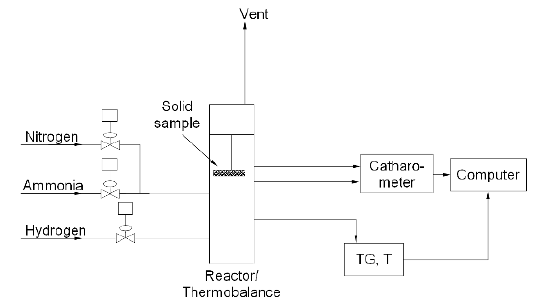
Figure 1. Reactor with thermogravimetric measurement and concentration analysis of hydrogen in gas